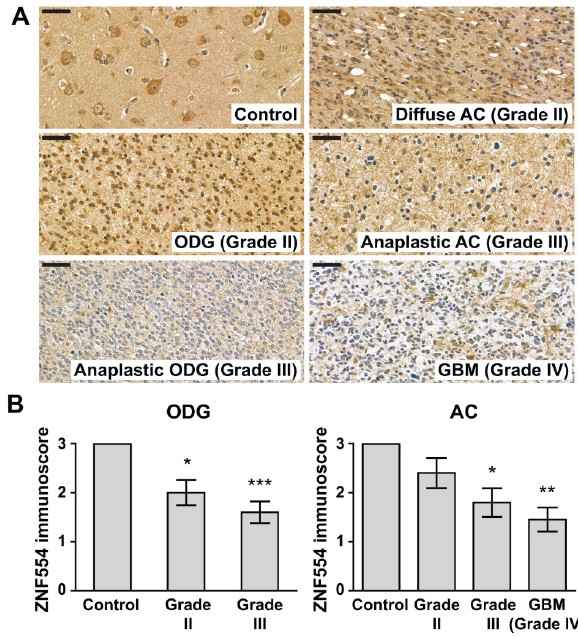
Figure 1. Zinc finger protein 554 (ZNF554) expression is decreased at the protein level in gliomas. ( A ) 5- µ m-thick brain sections from controls ( n = 11) and from patients with grade II ( n = 10) or grade III ( n = 10) oligodendroglioma, grade II ( n = 10) or grade III ( n = 10) astrocytoma, or glioblastoma ( n =